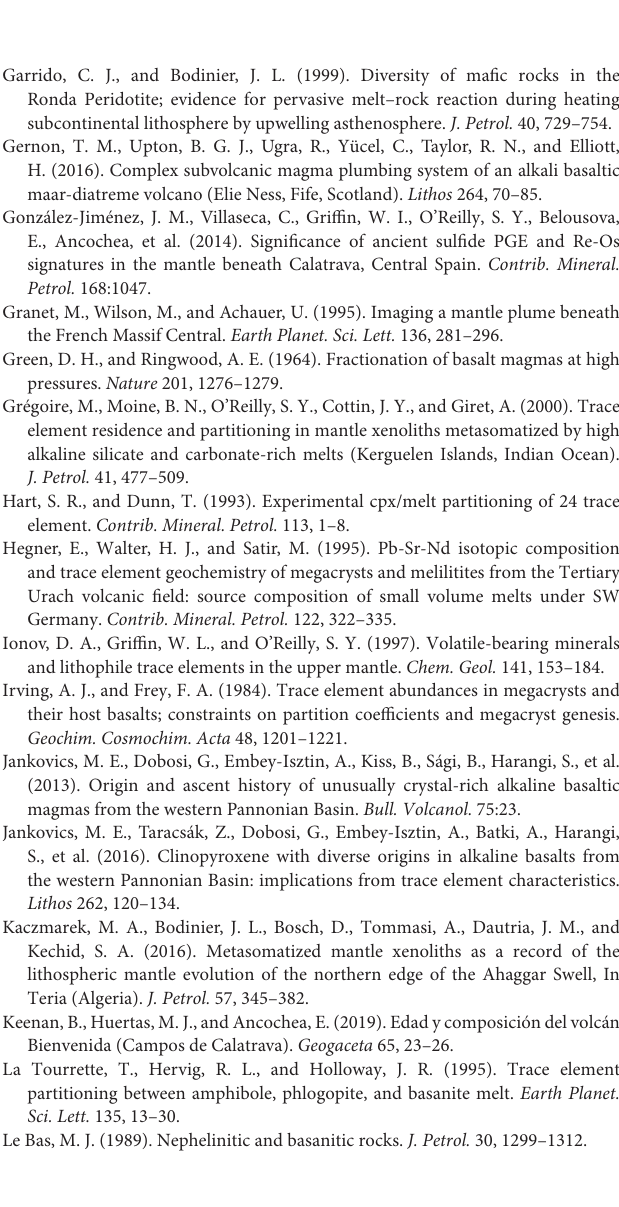
FIGURE S1 | (A) The Calatrava Volcanic Field and location of the two studied volcanoes: El Aprisco and Cerro Pelado (Ancochea, 1982; Cebriá et al., 2011). (B) Sketch map of the Iberian Peninsula showing the location of the main Cenozoic volcanic fields (in black; Lustrino and Wilson, 2007). TABLE S1 | Compositional data on certified standards analyzed with the samples in this study. TABLE S2 | Clinopyroxene trace element contents (in ppm) in megacrysts, phenocrysts and pyroxenite enclaves. TABLE S3 | Amphibole and phlogopite trace element contents (in ppm) in megacrysts, phenocrysts and pyroxenite